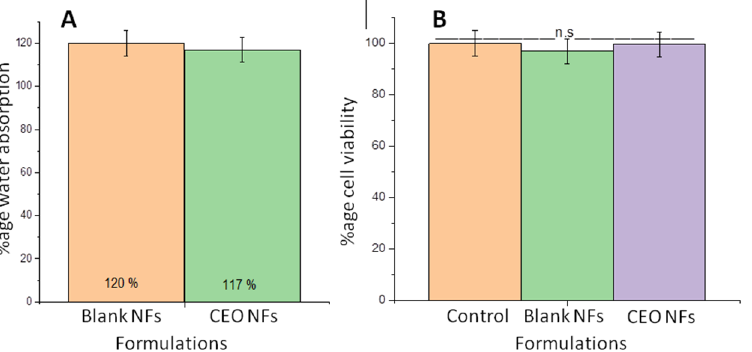
Figure 6. Percentage water absorption by blank NFs and CEO-encapsulated NFs ( A ) and cell viability percentage blank NFs and CEO NFs against fibroblasts cell lines after 48 hours incubation ( n = 6, (ns = p > 0.05) ( B ).